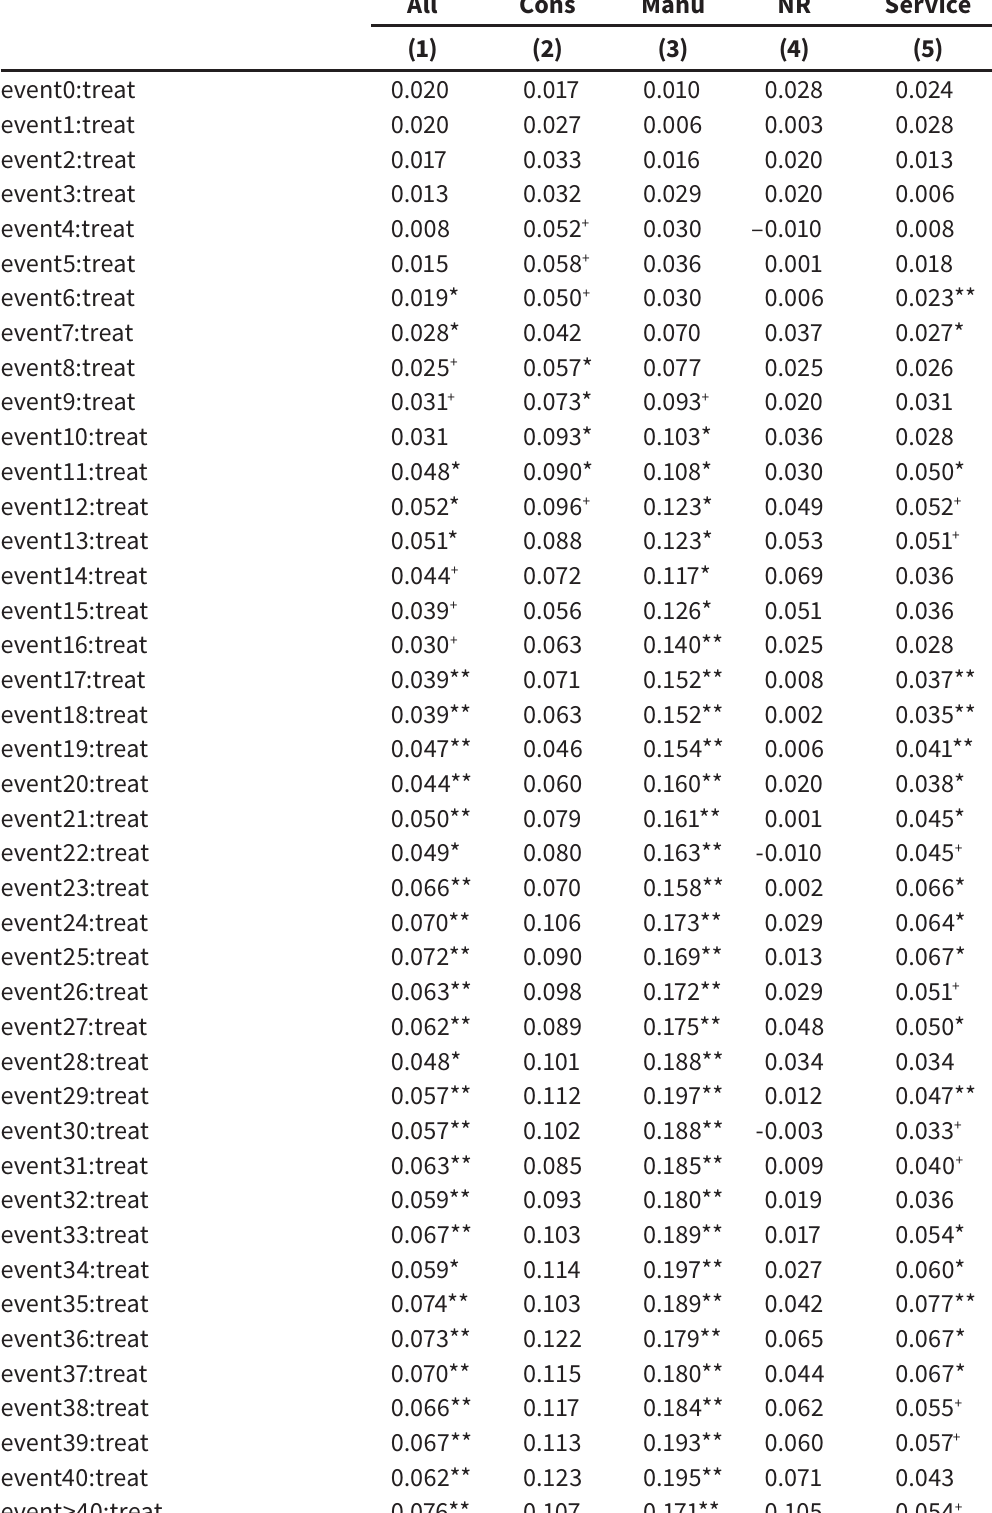
Table A4 Event study estimates post-dispensary entry periods for employees, by